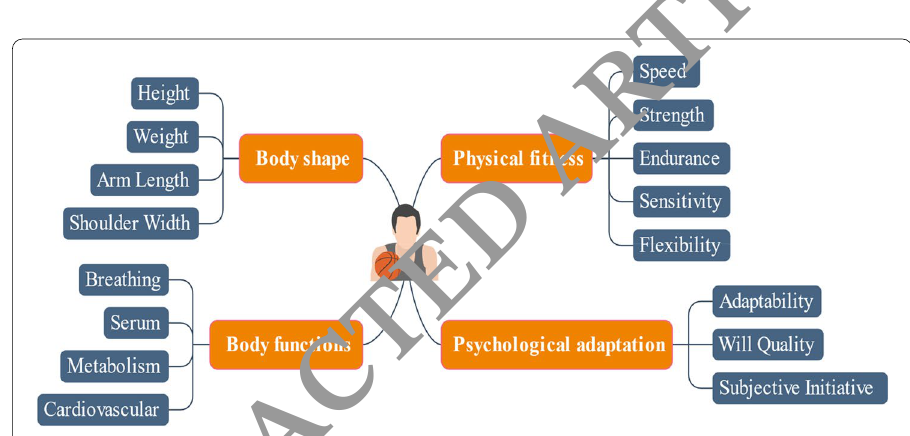
Fig. 2 Specific evaluation indicators of basketball